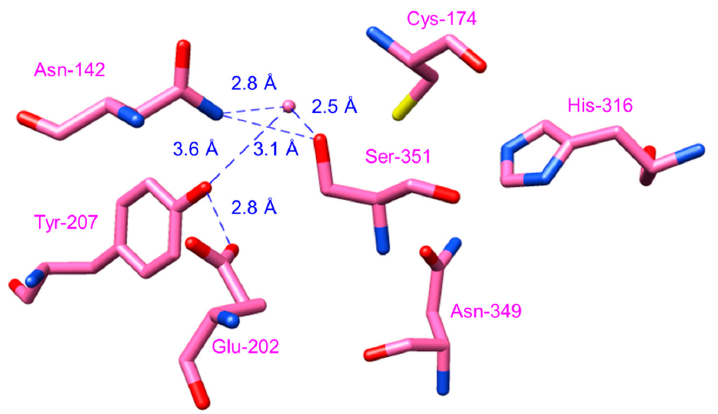
Figure 8. Hydrogen-bond network of CUS (PDB ID: 3ALE) consisting of Ser351, Asn142, Tyr207, Glu202, and a water molecule near the catalytic Cys174.